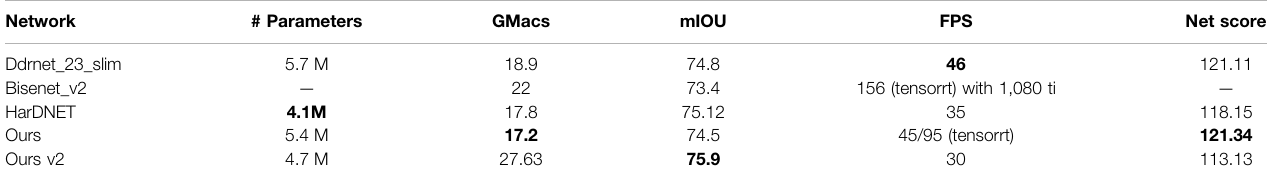
TABLE3| ThecomparednetworksarehighrankedintheCityscapereal-timebenchmark.ThemIOUresultsarewithvalidationdataset.TheFPSofBisenet_v2isona1,080 ti but our network is on a 1,080 which has less powerful resources than a 1,080 ti. Ours v2 is described in the Supplementary Material . Network # Parameters